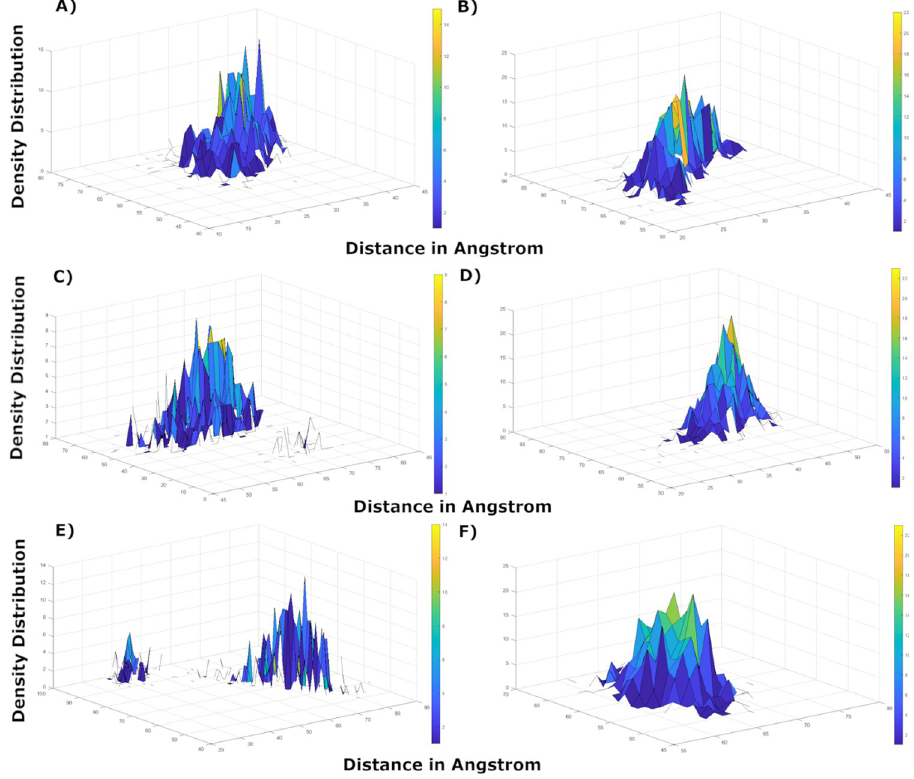
Fig 11. AFD plots to compare point of coordinates and geometry of a) Calceolarioside_B at 10 ns, b) Calceolarioside_B at 400 ns, c) Luteolin-7-O-glucopyranoside at 10 ns, and d) Luteolin-7-O-glucopyranoside at 200